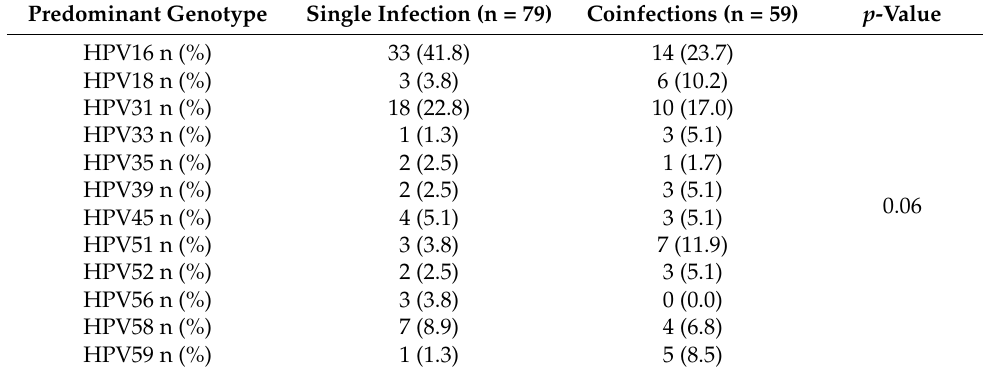
Table 3. HR-HPV genotype distribution in women with single and multiple HR-HPV infections.